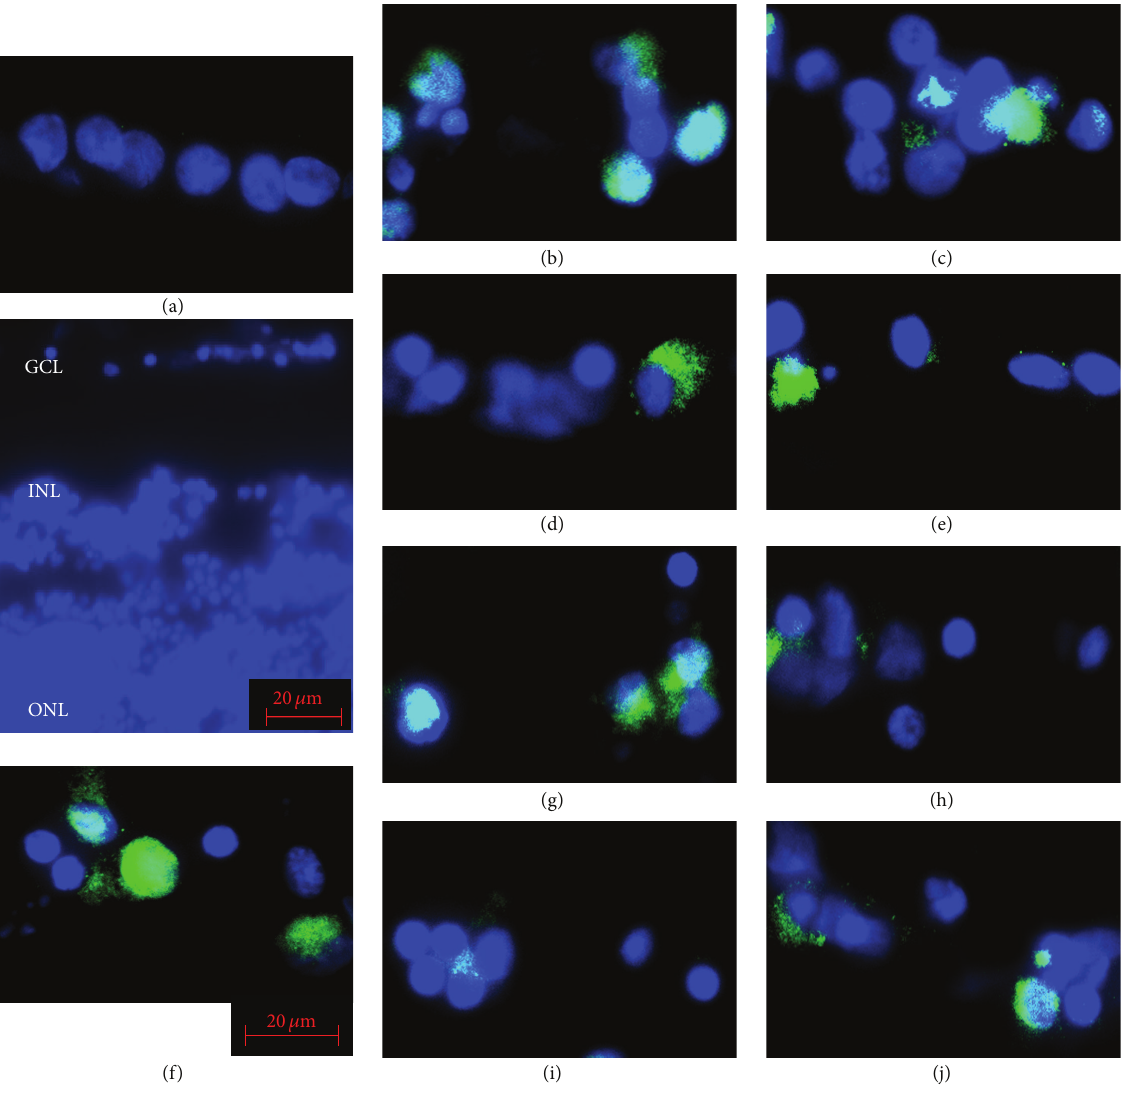
Figure 4: Representative photomicrographs of SP1 immunopositive cells in the ganglion cell layer (GCL) of isolated rat retinas. In retinas cultured in glucose-AGE-BSA (f), the number of immunopositive cells in the GCL is significantly higher than in serum-free control media (a). In AGEs exposed retinas supplemented with NT-4 (glucose-AGE-BSA + NT-4) (g), with HGF (glucose-AGE-BSA + HGF) (h), with GDNF (glucose-AGE-BSA + GDNF) (i), and with TUDCA (glucose-AGE-BSA + TUDCA) (j) the number of SP1 immunopositive cells is higher than that in AGEs exposed retinas without neurotrophic factors. The blue signals show the DAPI-stained nuclei. Panels (b), (c), (d), and (e) show the representative pictures of the serum-free media incubated with NT-4 (b), HGF (c), GDNF (d), and TUDCA (e). INL, inner nuclear layer; ONL, outer nuclear layer. Bar = 20 𝜇